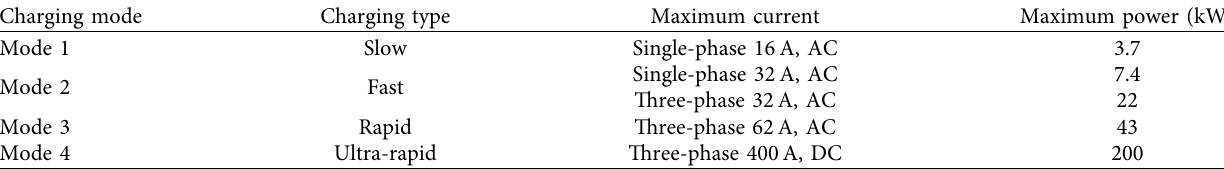
Table 3: Charging modes based on IEC